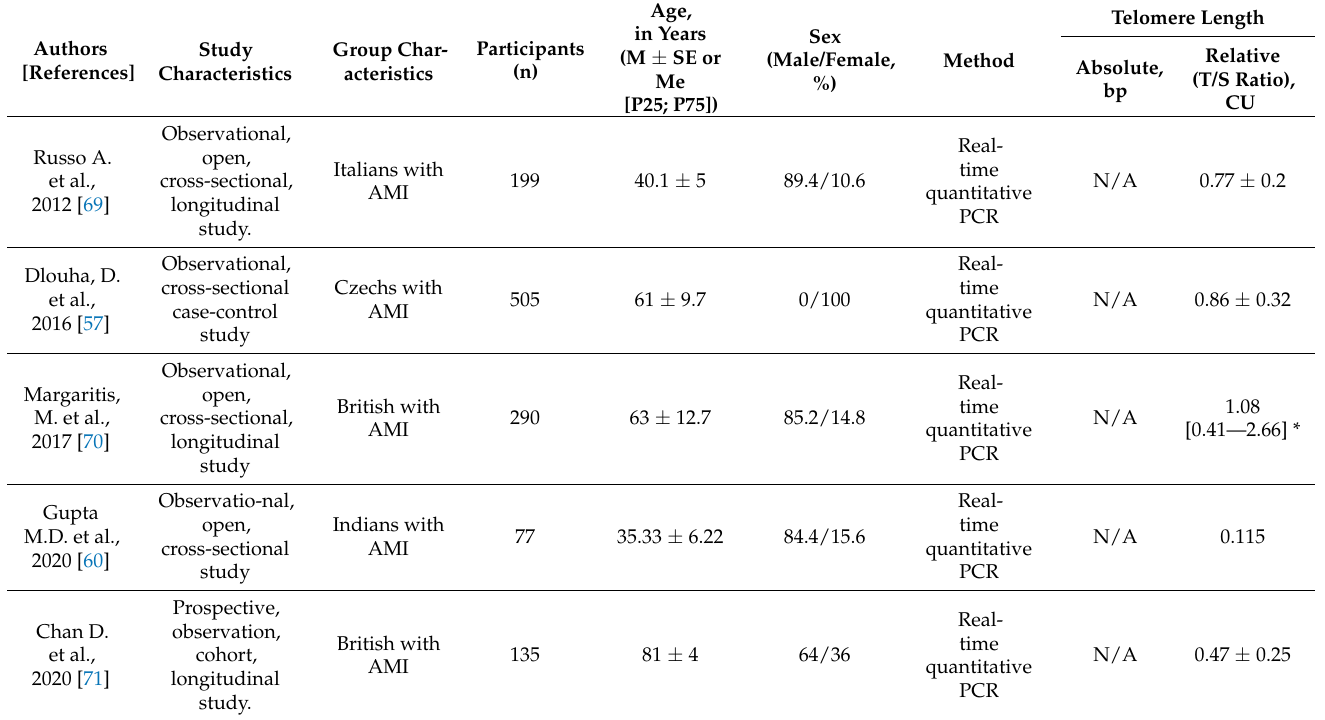
Table 3. Mean Relative Telomere Length of Leukocytes in Adults with Acute Myocardial